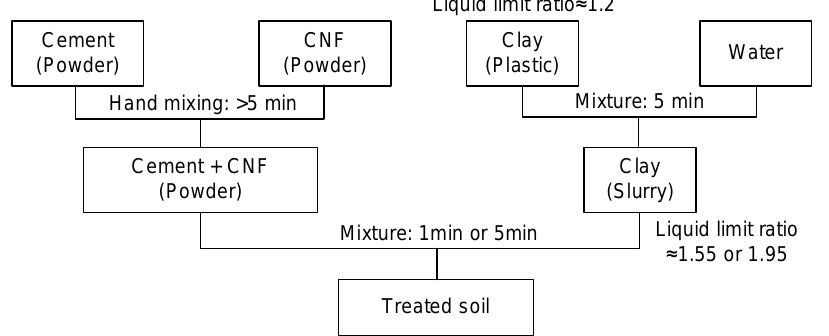
Figure 3. Mixture procedure for preparing specimens (Method 2).